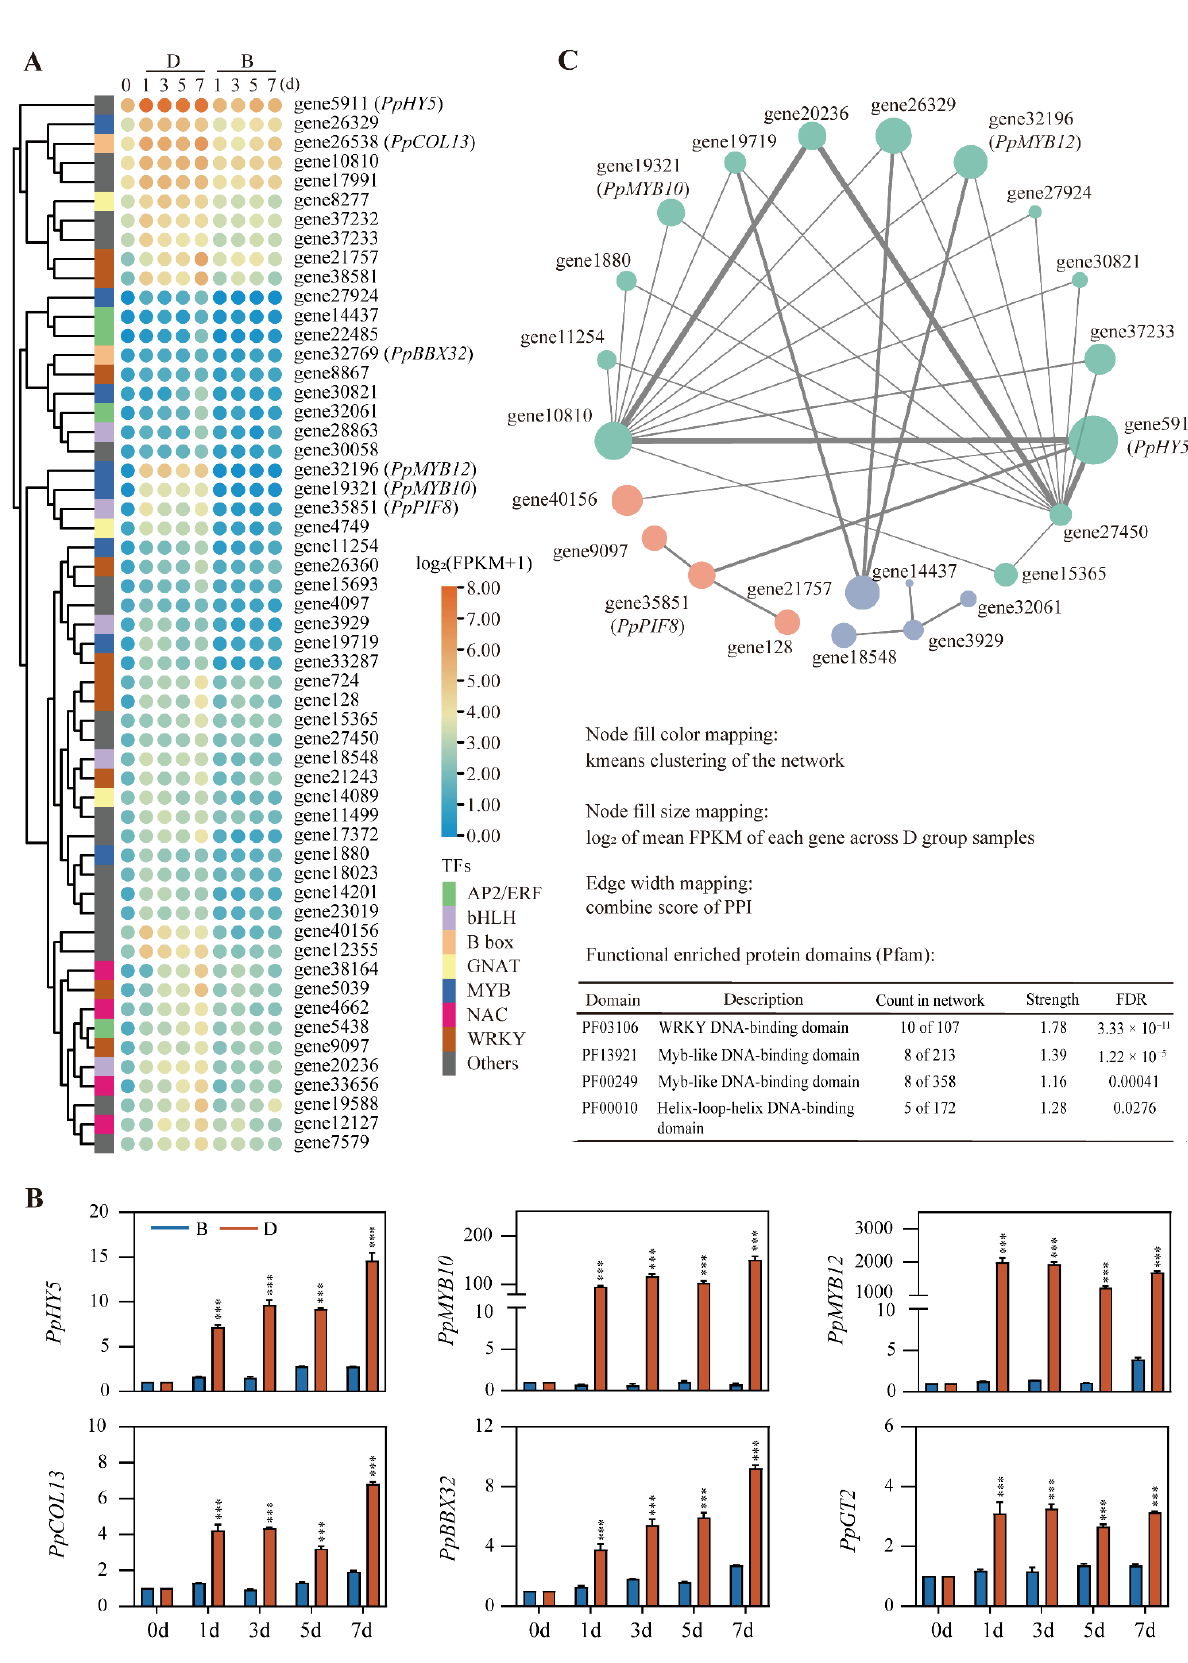
Figure 6. Analysis of transcription factors. ( A ) Cluster analysis of 55 transcription factors expression in “Blue” and “Turquoise” modules. ( B ) Validation of transcription factor expression by RT-qPCR.